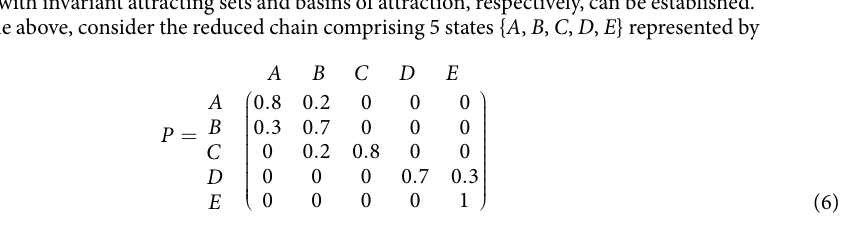
B B # of particles in (1) ij